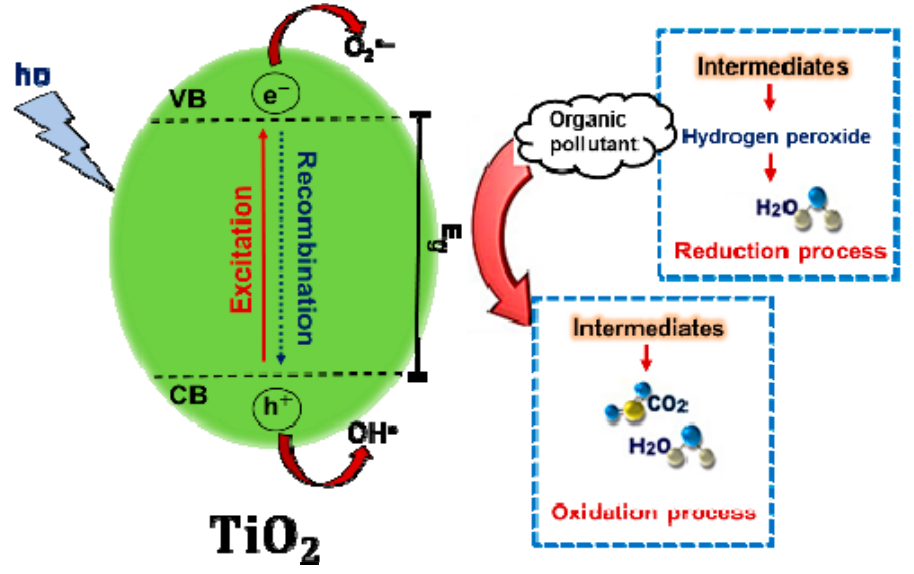
Figure 1. Schematic illustration of typical photocatalysis over TiO 2 . Photoexcitation results in the formation of photogenerated electron–hole pairs, and the generated charge pairs can either contribute to a chemical reaction with